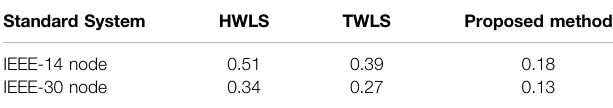
TABLE 5 | Average absolute error of voltage phase angle under non-Gaussian noise ( °